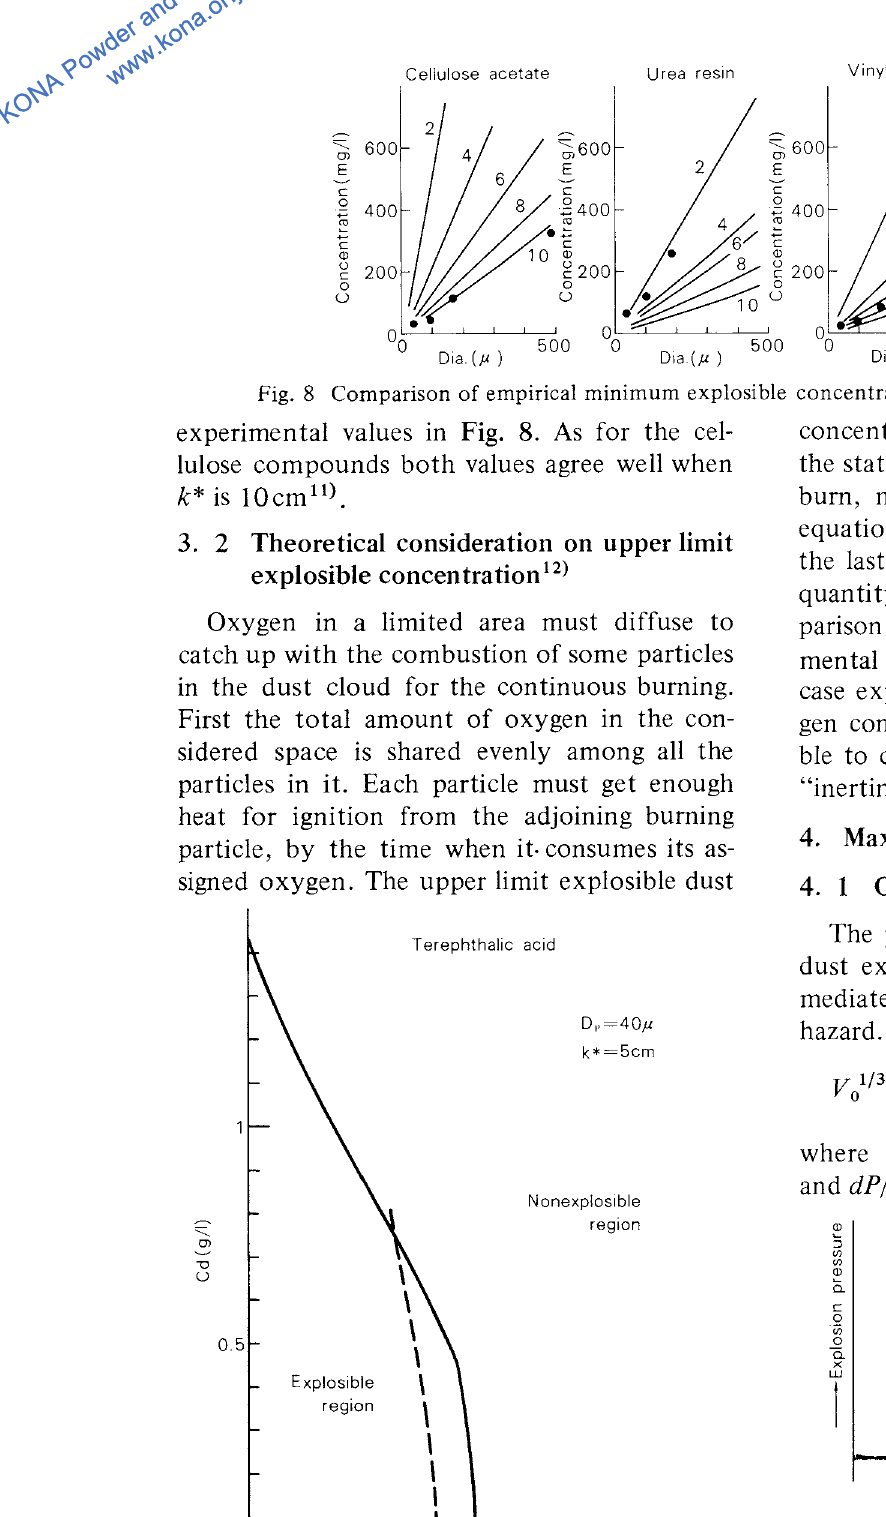
Fig. 9 Upper and lower explosible limits of dust concentration of terephthalic acid in relation to oxygen